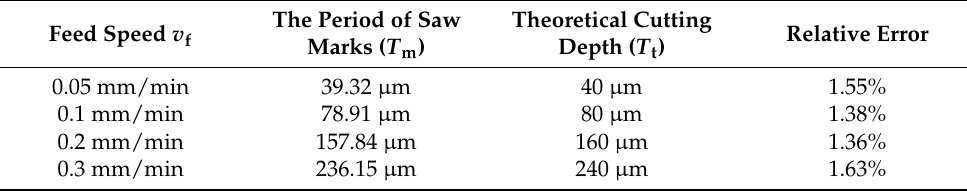
Table 6. Period of saw marks and the theoretical cutting depth at P = 0.21 MPa, v s = 1.8 m/s. The Period of Saw Theoretical Cutting Relative Error Feed Speed v f Marks ( T m ) Depth ( T t )